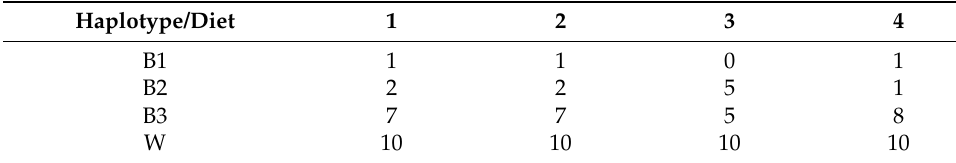
Table 4. Number of individuals per haplotype and diet obtained from experiment